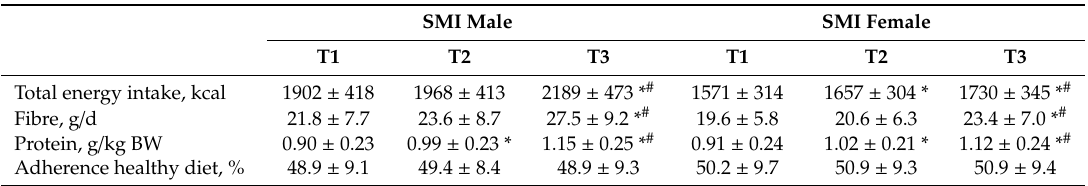
Table 3. Fibre, protein and total energy intake and adherence to healthy diet in sex-specific tertiles of Adherence healthy diet, % skeletal muscle mass index.